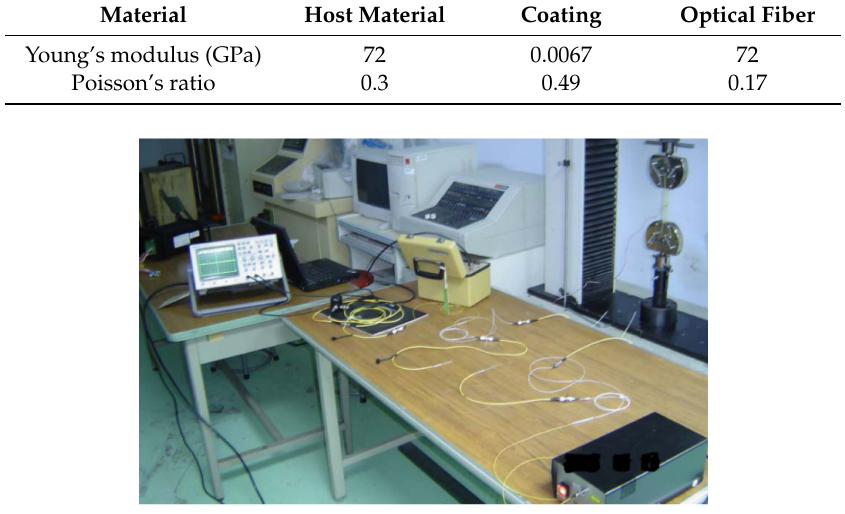
Figure 3. Experimental setup of the tensile test measured by Mach–Zehnder